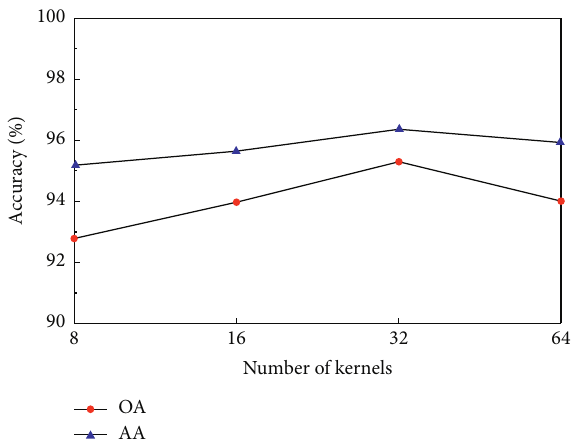
Figure 5: The influence of the number of convolution kernels on classification accuracy.